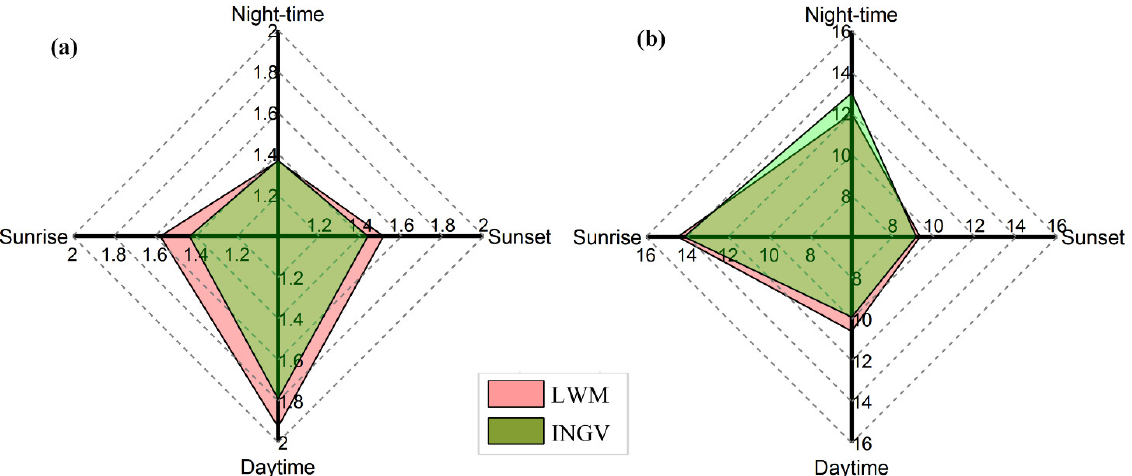
Figure 5. The prediction error of MUF during the different periods of sunrise, daytime, sunset, and nighttime: ( a ) RMSE, ( b ) RRMSE.